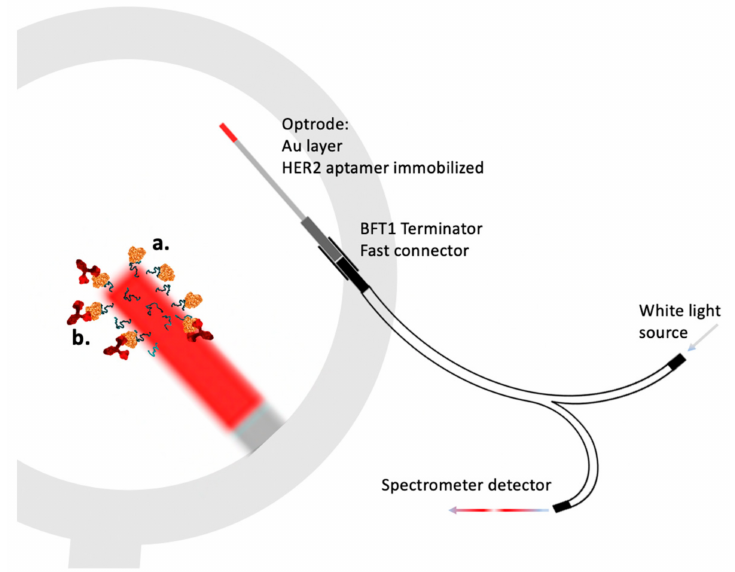
Figure 11. SPR optrode (a). First fast stage of HER2 capture by Au-bound aptamers. (b) Second long stage of the amplification of the signal with HER2 specific antibody adsorption on the fiber surface to enhance the signal 100-fold [71] with permission from